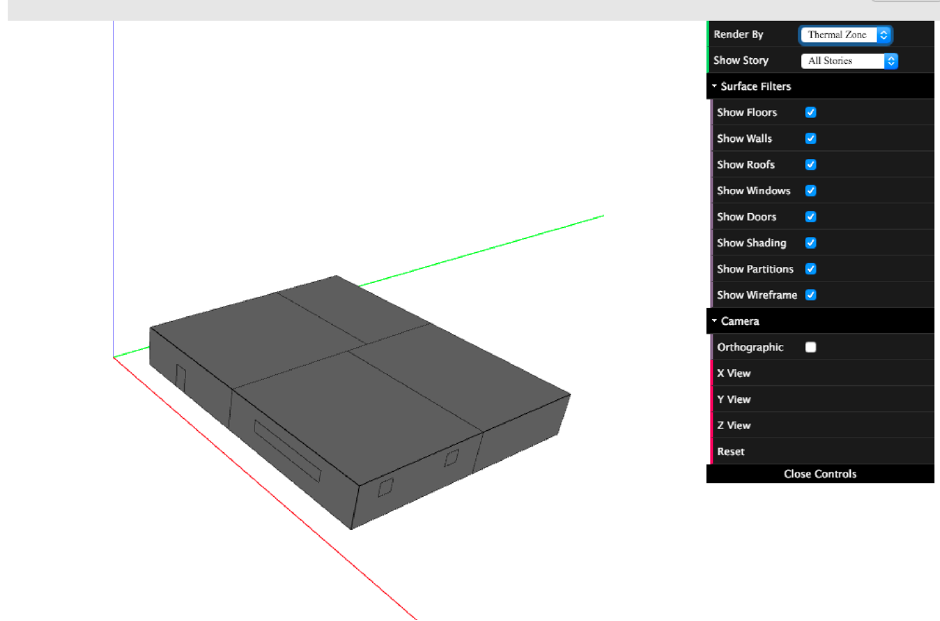
Figure 8. Single thermal zone representation of a multi-zone